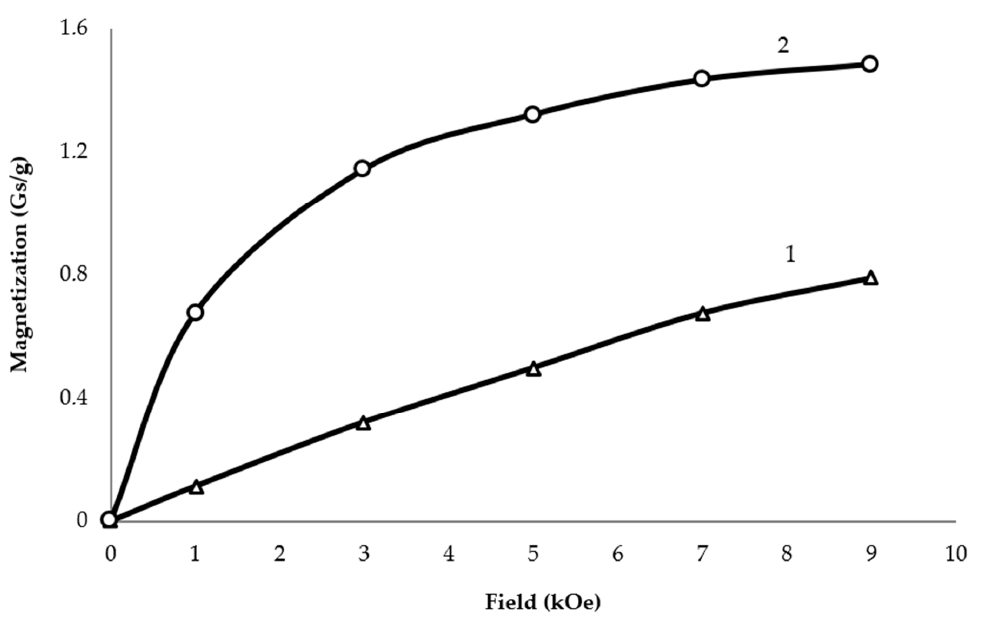
Figure 1. Magnetization curves for 10% Ni / Al 2 O 3 (1) and 10%Ni-1.5% Cr / Al 2 O 3